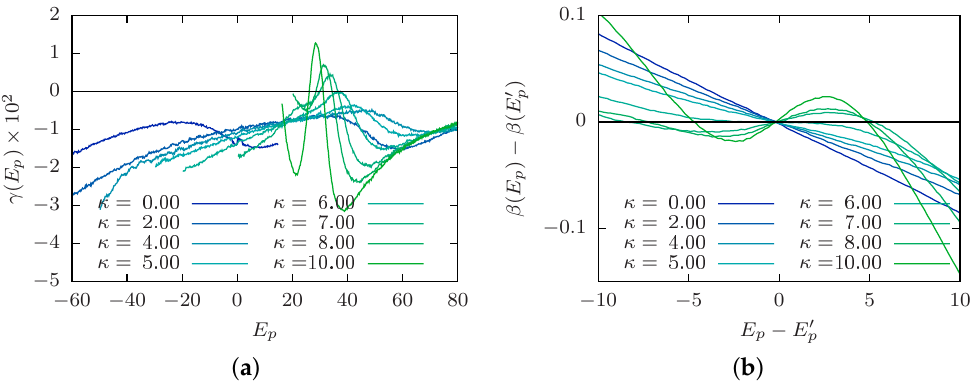
Figure 2. Microcanonical analysis of the collapse transition line for a bead-spring polymer ( N = 40). ( a ) The transition energies E (cid:48) p are identified as the peak location of γ ( E p ) . It can be seen that for low κ , the transition peak is below zero (second order), but with increasing κ , there is a crossover to peaks above zero (first order). ( b ) A rescaled plot of the microcanonical inverse temperature β ( E p ) − β ( E (cid:48) p ) around the transition energy E p − E (cid:48) p shows the crossover from second-order (no back-bending) to first-order transition